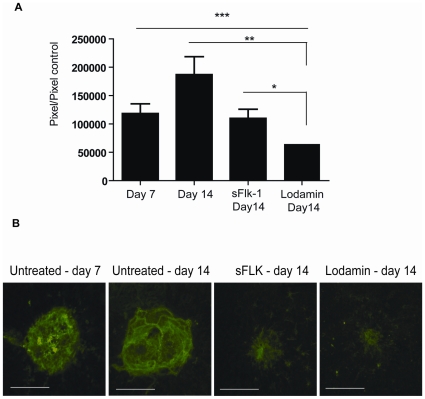
Comparison of the effect of Lodamin or sFlk-1 on choroidal vessel regression.For CNV regression studies intravitreal injections of Lodamin or sFlk-1, a recombinant mouse VEGF R2/KDR Flk-1 Fc Chimera, were performed on established CNV lesions at day 7 post laser induction. After 14 days of laser induction (7 days post intravitreal injection of Lodamin or sFlk-1) fluorescent images of choroidal flat-mounts were captured and CNV area (presented in µm2) in choroidal flat mount was evaluated using Scion image software. (A) CNV size data of untreated mice bearing laser induced CNV at day 7 and 14, compared to Lodamin or sFlk-1 treated mice 7 days after their injection. Data is presented as mean pixel number ± SEM (n = 15–27 spots, *P<0.05, U-test).